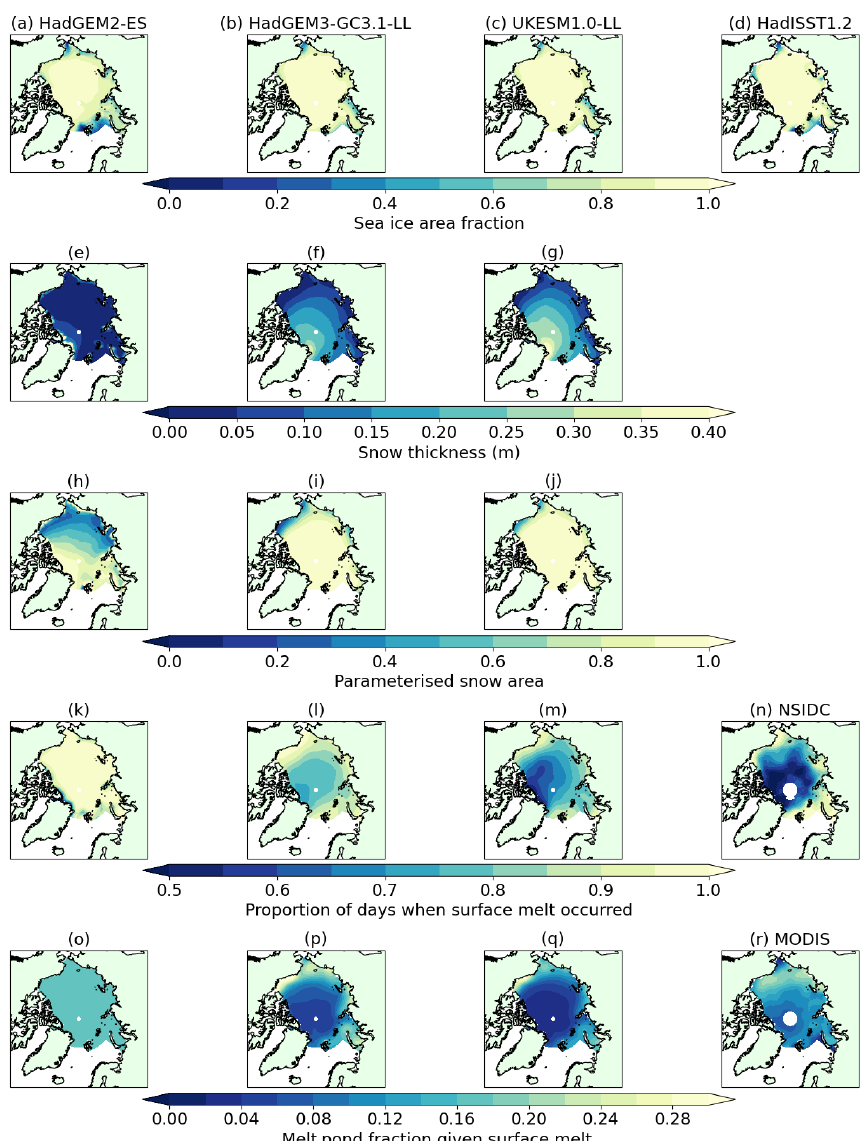
Figure 4. The 1980–1999 June averages of variables affecting surface albedo in HadGEM2-ES (first column), HadGEM3-GC3.1-LL (second column) and UKESM1.0-LL (third column), compared where appropriate to observational datasets (fourth column) and showing (a–d) sea ice area fraction, (e–g) snow thickness, (h–j) parameterised snow area fraction, (k–n) proportion of time in June during which surface melting conditions were present and (o–r) melt pond area fraction during times in which surface melting conditions were present. Note that in panel (r) MODIS melt pond fraction is for the period